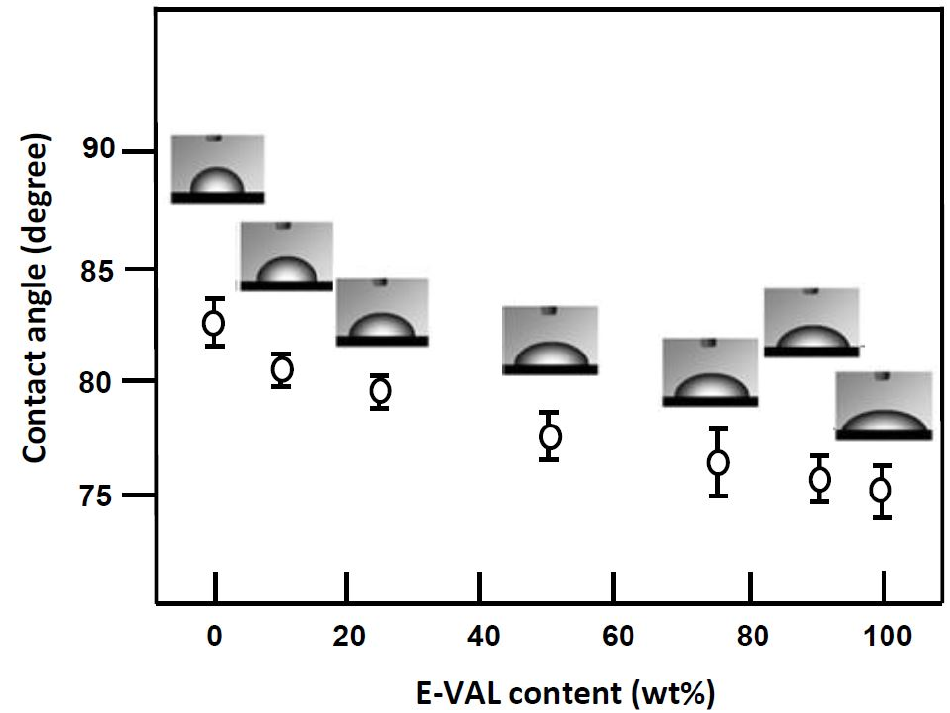
/ PCL blend versus the E-VAL